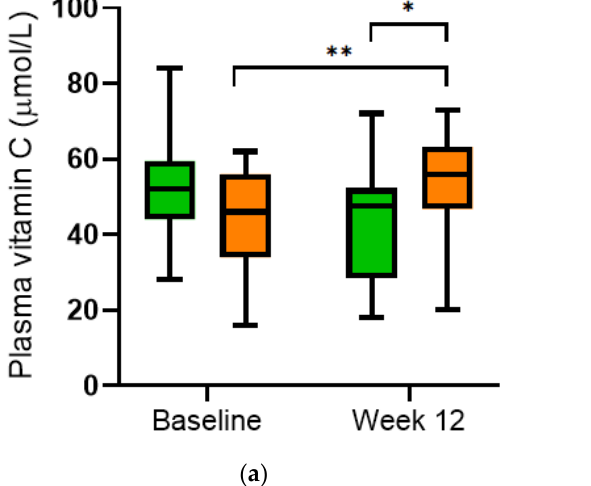
Figure 7. Plasma vitamin C concentrations before and after intervention. ( a ) Vitamin C increased over time in the intervention group (orange boxes; ** p = 0.007) and relative to placebo at week 12 (green boxes; * p = 0.01). ( b ) Categories of vitamin C status: hypovitaminosis C ( ≤ 23 µ mol/L; orange bars), inadequate (<50 µ mol/L; yellow bars), adequate ( ≥ 50 µ mol/L; green bars), saturating ( ≥ 70 µ mol/L; blue bars). Pl., placebo; Int.,